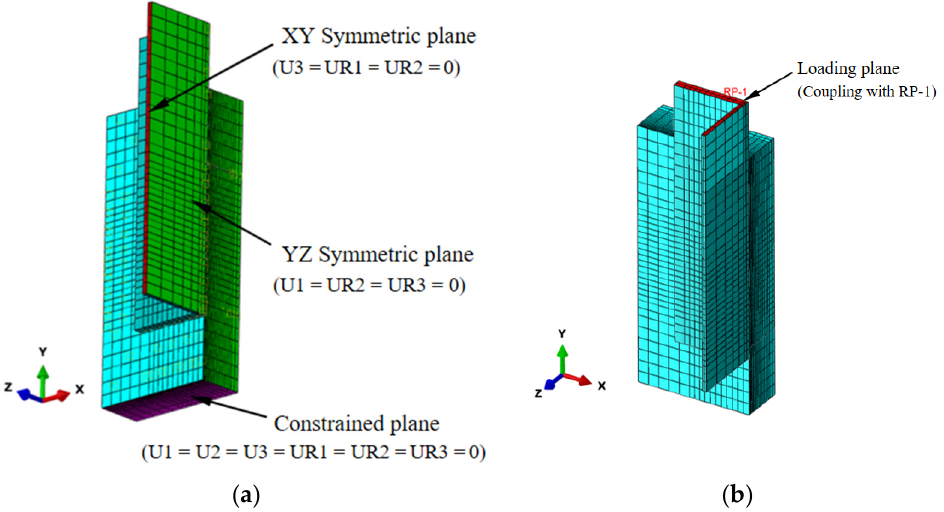
Figure 9. Boundary conditions and load application: ( a ) boundary conditions; ( b ) load application.